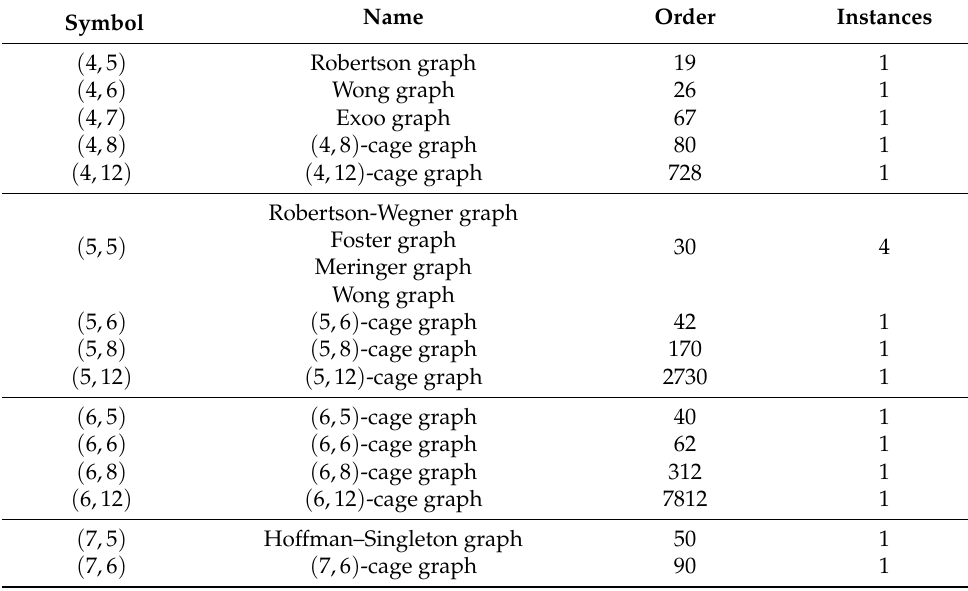
Table 4. Known ( r , g ) -cage graph classification for r >